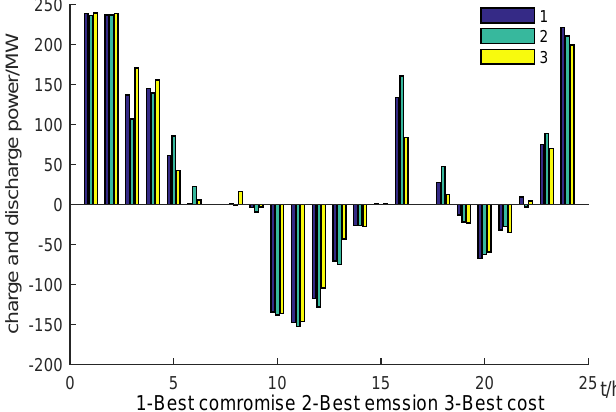
Figure 10. Comparison of EVs charge/discharge power among different solutions.